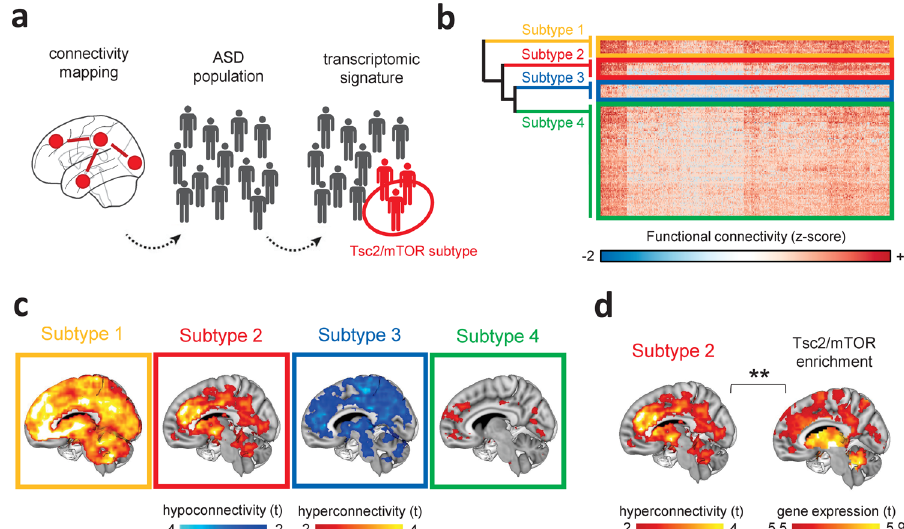
Fig. 5 Identi fi cation of a Tsc2/mTOR-enriched hyperconnected ASD neuro-subtype. a Illustration of the neuro-functional subtyping we used to identify the sub-population of ASD individuals enriched for Tsc2-mTOR network genes. RsfMRI connectivity mapping was applied to the heterogeneous population of ASD individuals followed by hierarchical clustering. Gene decoding and enrichment analysis were then applied to identify the ASD subtype that is most enriched for Tsc2/mTOR network genes. b The heatmap shows the four clusters identi fi ed with agglomerative hierarchical clustering. c Intergroup comparisons showed clear subtype-speci fi c functional connectivity fi ngerprints, i.e., alterations of rsfMRI connectivity in ASD vs. TDs for each cluster. d Gene enrichment highlighted that only ASD subtype 2 was signi fi cantly enriched for mTOR/Tsc2 genes. ** P <